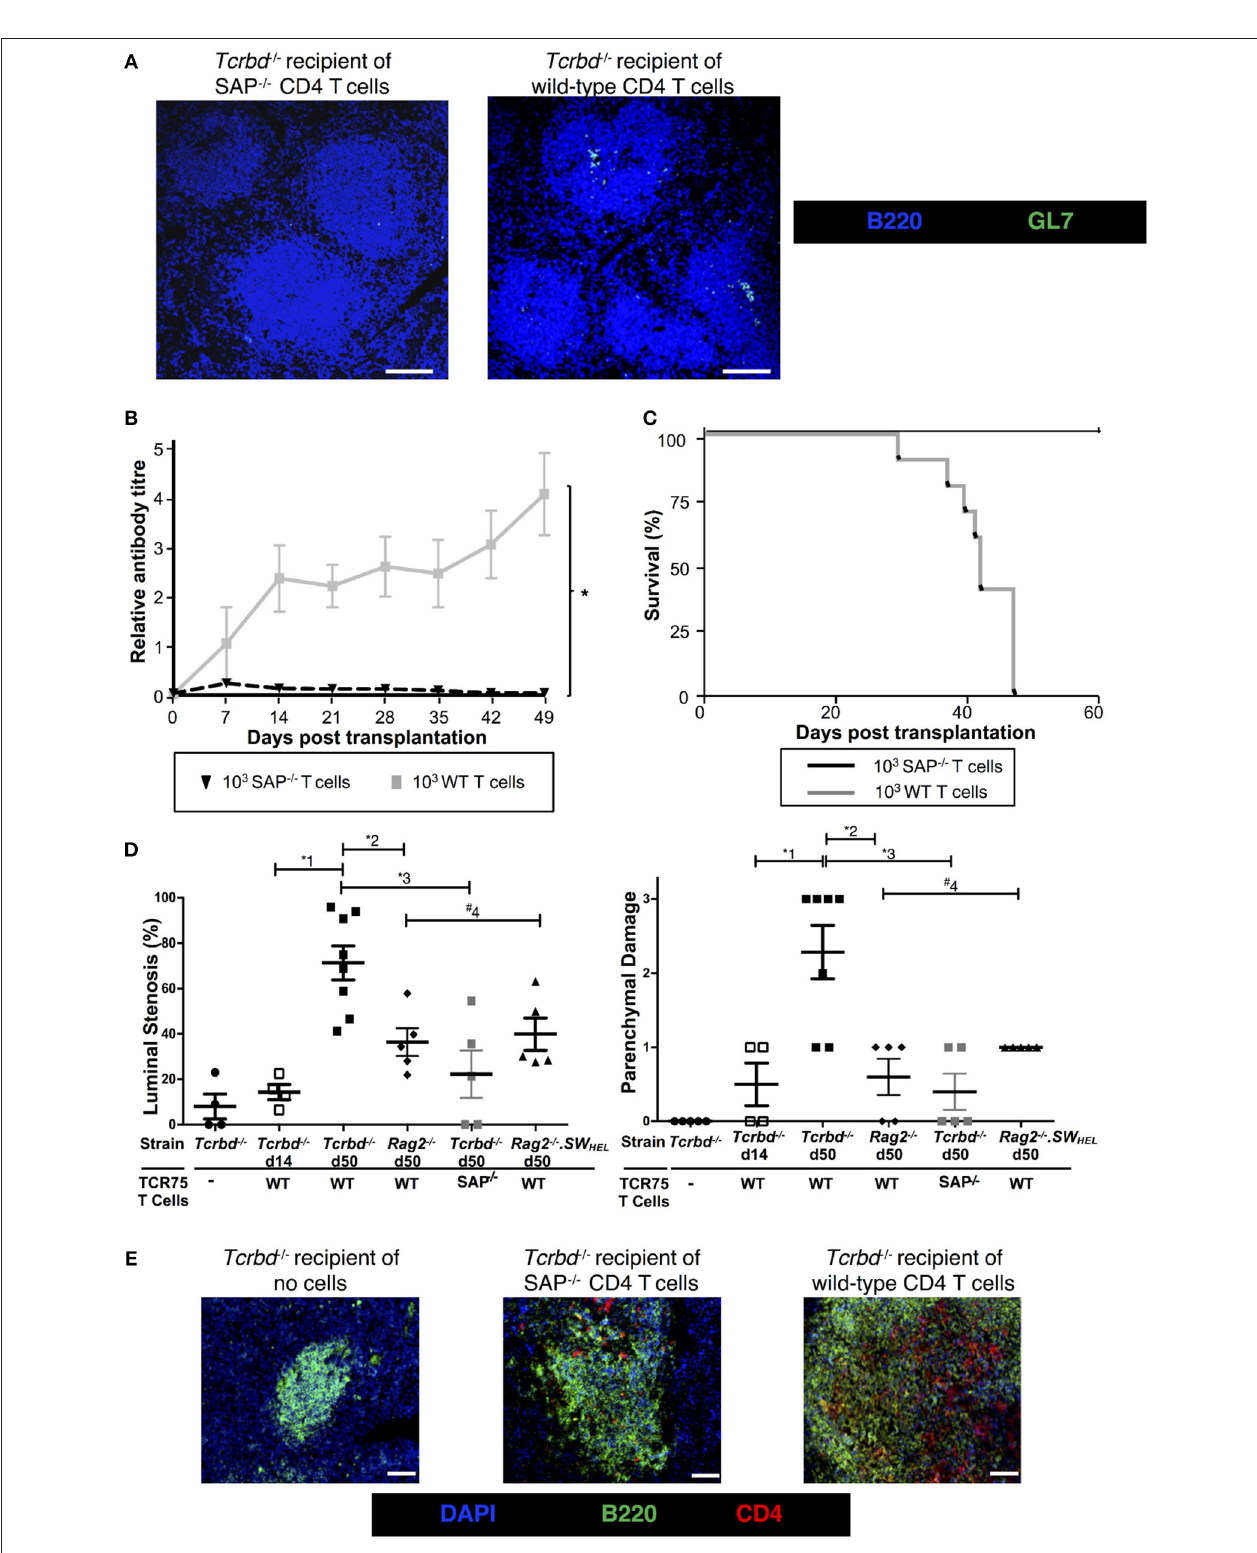
FIGURE 5 | Germinal center alloantibody responses mediate chronic allograft rejection. (A) Representative low magnification confocal immunofluorescence photomicrographs of splenic B cell follicles stained with antibodies against B220 (B cells, blue) and GL7 (GC B cells, green) at d50 from BL/6 Tcrbd − / − recipients of BALB/c heart grafts adoptively transferred with 10 3 Sh2d1a − / − (left) or wild-type (right) TCR75 CD4T cells (scale bar – 200 µ m). (B) Anti-H-2K d alloantibody